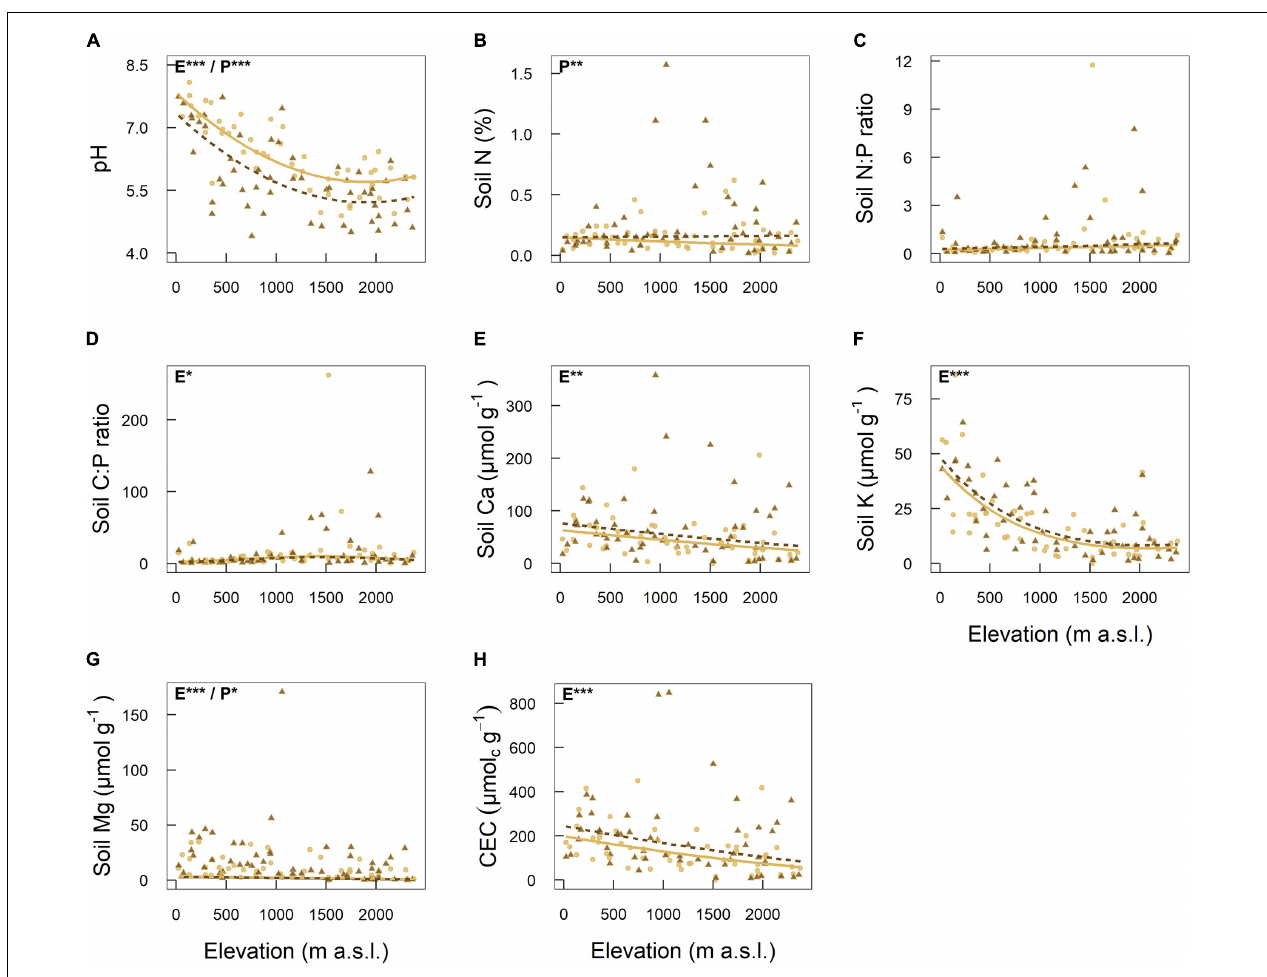
FIGURE 3 | Elevational variation of eight chemical soil properties: (A) pH, (B) Soil nitrogen, (C) Soil nitrogen to phosphorus ratio, (D) Soil carbon to phosphorus ratio, (E) Soil calcium, (F) Soil potassium, (G) Soil magnesium, (H) Cation exchange capacity. Linear mixed-effects models were fitted separately for each soil property as response to elevation (first or second-order polynomial), road proximity (roadside or distant plot), and their interaction. Sampling location nested in road identity, which corresponds to the sampling design, was included as random effect. Light brown continuous lines and circles represent plots next to the road (roadside plots). Dark brown dashed lines and triangles represent plots away from the road in natural vegetation (distant plots). For soil pH, C:P ratio and K the model including the quadratic term of elevation had a higher explanatory power (lower AIC) compared to the model including only the linear term of elevation. Significant terms are indicated at the top left of each plot: “E” corresponds to elevation and “P” to road proximity. Significance levels are indicated as follows: < 0.001 = ∗∗∗ , < 0.01 = ∗∗ , < 0.05 = ∗